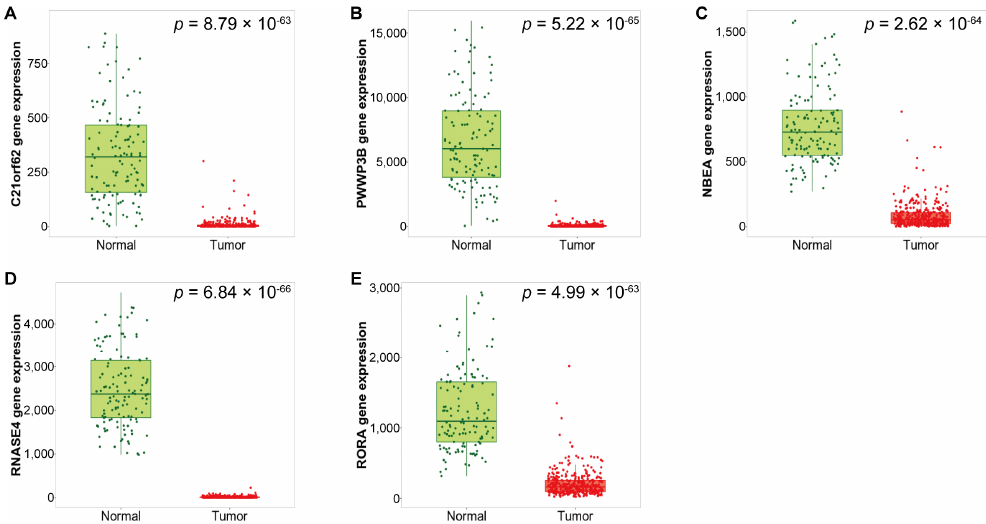
Figure 4. Box plots of down-regulated DEGs expression between normal and serous ovarian cancer tissues in the RNA-seq dataset of TCGA OV. ( A ) C21orf62 , ( B ) PWWP3B , ( C ) NBEA , ( D ) RNASE4 , and ( E ) RORA mRNA expression. Table 5. Down-regulated DEGs in serous ovarian cancer of the RNA-seq dataset of TCGA OV. Gene Names